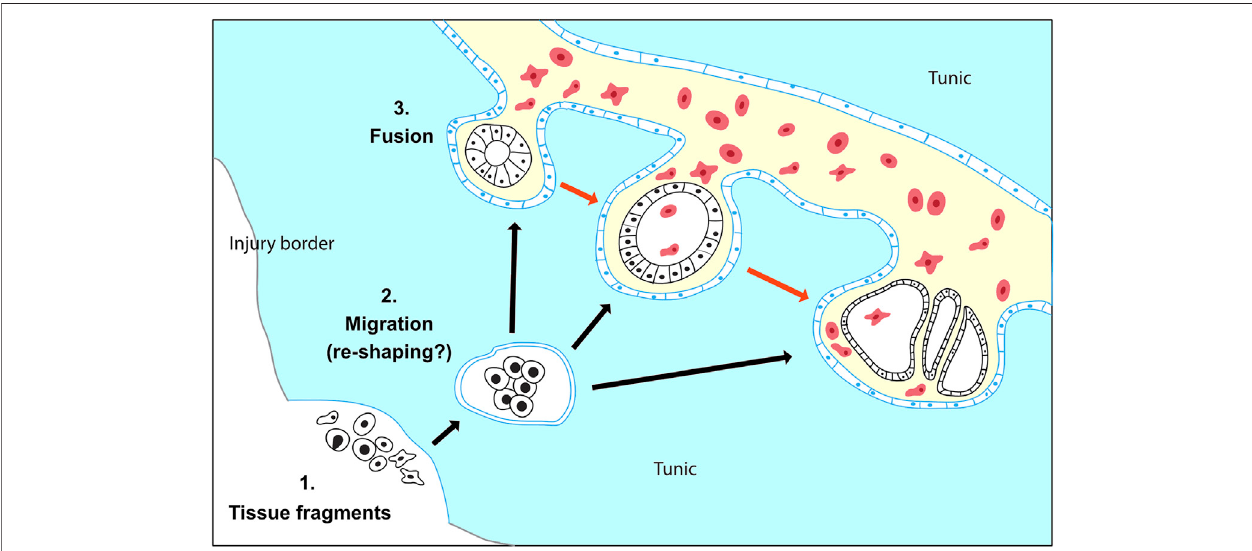
FIGURE 8 | Proposed model for WBR in Botryllus schlosseri . (1) WBR originates from heterogeneous tissue fragments of the adult zooid, which have been left behind during injury. (2) The tissue fragments migrate through the tunic (black arrows) and possibly re-shape into spherical vesicles enclosed by a monolayered epithelium(blue).(3)Thedoublevesiclesfusewiththevasculatureandreleasetheinnervesicle(black)inthevascularsystem.Thevesiclesproliferateanddevelopintothe regenerating zooid (red arrows). The exact nature of the leftover cells and the dynamic of tissue reshaping during tissue migration are